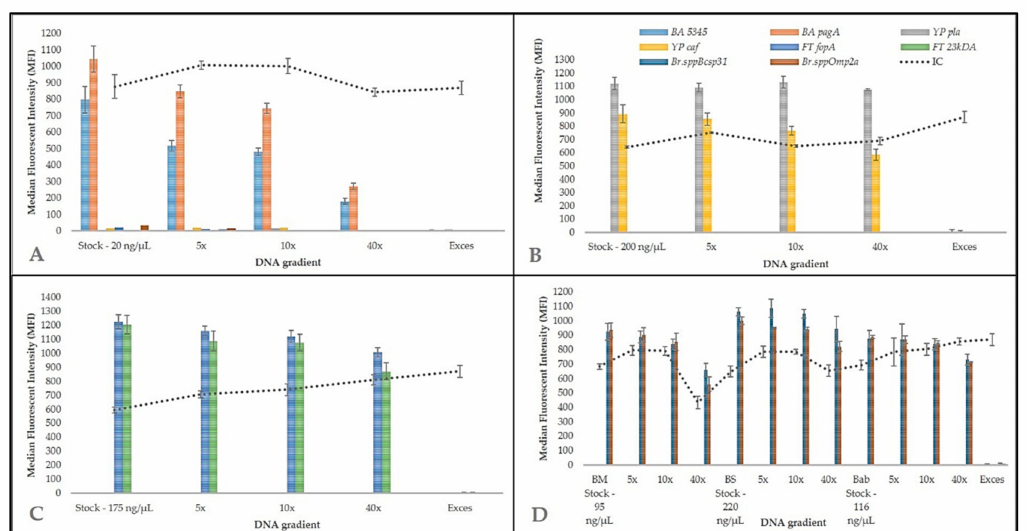
Figure 2. Biothreat detection panel. MOL-PCR biothreat assay for detection of ( A ) B. anthracis , ( B ) Y. pestis , ( C ) F. tularensis , and ( D ) Brucella spp. The biothreat panel was verified using DNA gra-dients from the collection of pathogenic microor- ganisms (CAPM) and evaluated by MFI after sub-tracting the NTC (H2O only) to the appropriate target. IC confirms that the individual reaction steps have taken place correctly. Exces (DNA from S. aureus ) was used for confirmation as another negative